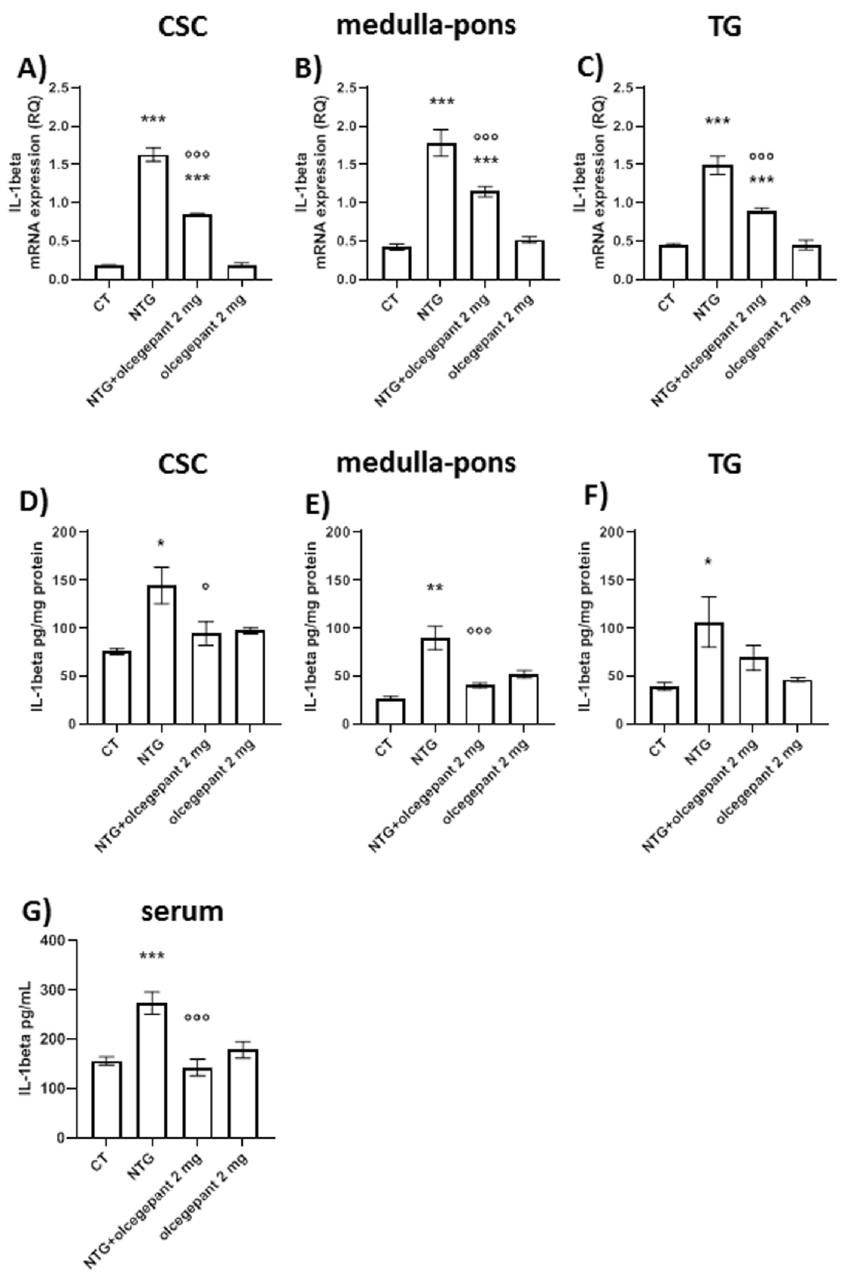
Figure 6. IL-1beta gene expression levels ( A – C ) and protein levels ( D – F ) in cervical spinal cord (CSC), medulla–pons and trigeminal ganglion (TG), and IL-1beta serum levels ( G ). mRNA levels are expressed as relative quantification (RQ); protein levels in tissues are expressed as pg/mg of protein and in serum are expressed as pg/mL. Data are expressed as mean ± SEM; one-way ANOVA followed by Tukey’s multiple comparisons test. * p < 0.05, ** p < 0.01, and *** p < 0.001 vs. control (CT) and olcegepant 2 mg; ° p < 0.05 and °°° p < 0.001 vs. nitroglycerin (NTG). These findings indicate that the release of cytokines is mediated by CGRP probably from the activated glial cells, which is responsible for the persistence of trigeminal